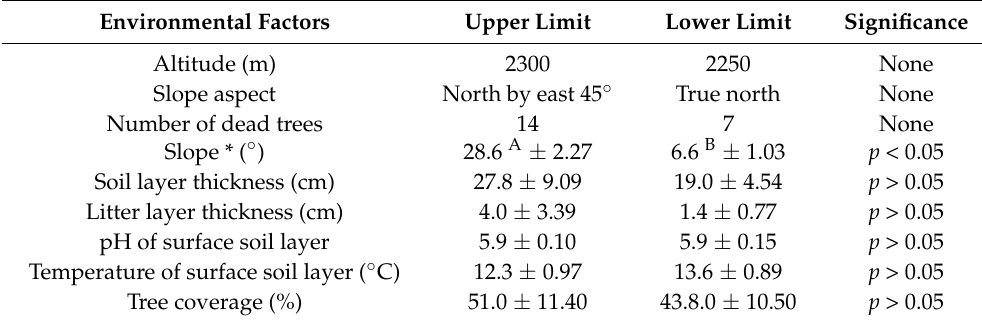
Table 1. Environmental conditions at the upper and lower limits.